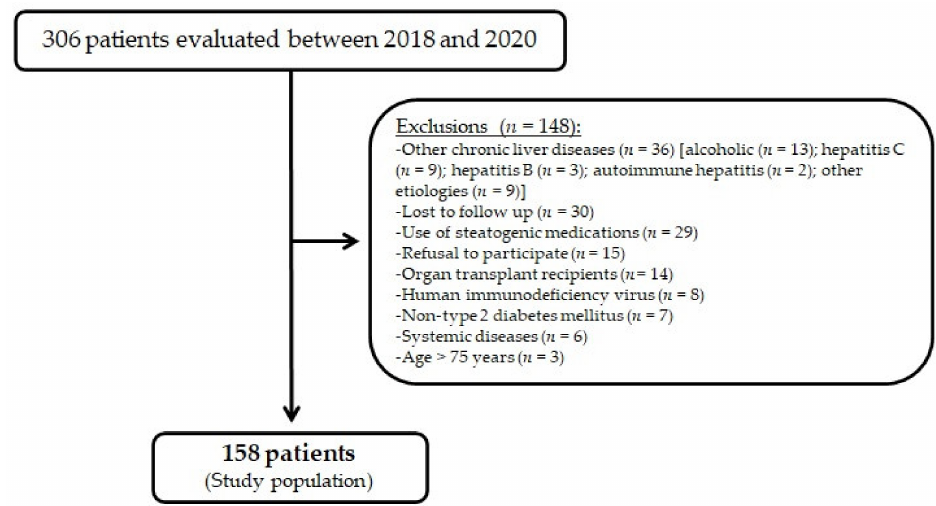
Figure 1. Flowchart of study population